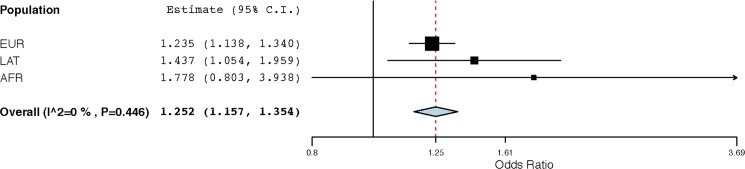
Forest plot for association of rs71404070 with rotator cuff injury.Only three race/ethnic populations yielded data for the lead SNP rs71404070: European, Latin-American and African-American. Effect size estimates with their 95% confidence intervals are given for each individual group, as well as the overall summary result. We observe little heterogeneity as measured by I2 (0%) and the p-value for Cochran’s Q statistic (0.446).